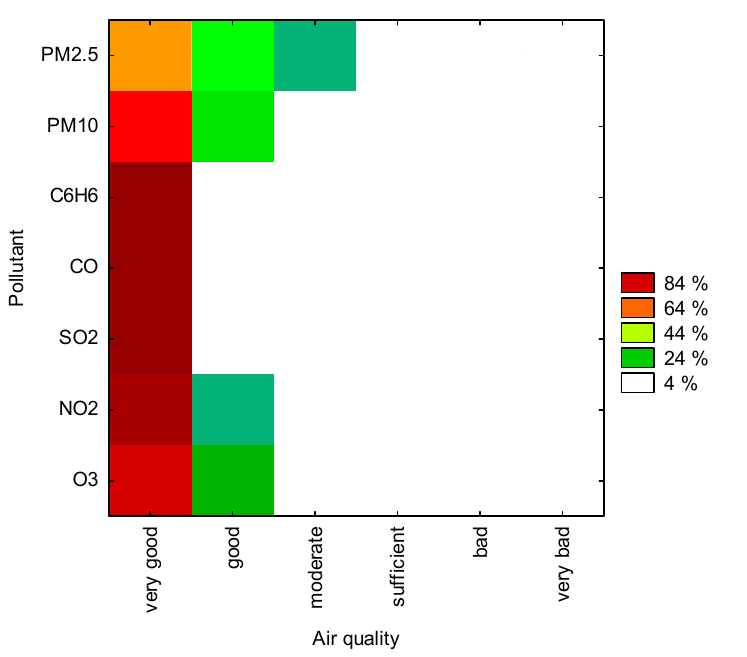
Figure 3. Similarities between air quality and chemical compound/particulate matter concentrations in percentage, using two-way joining cluster analysis. Source: own study.